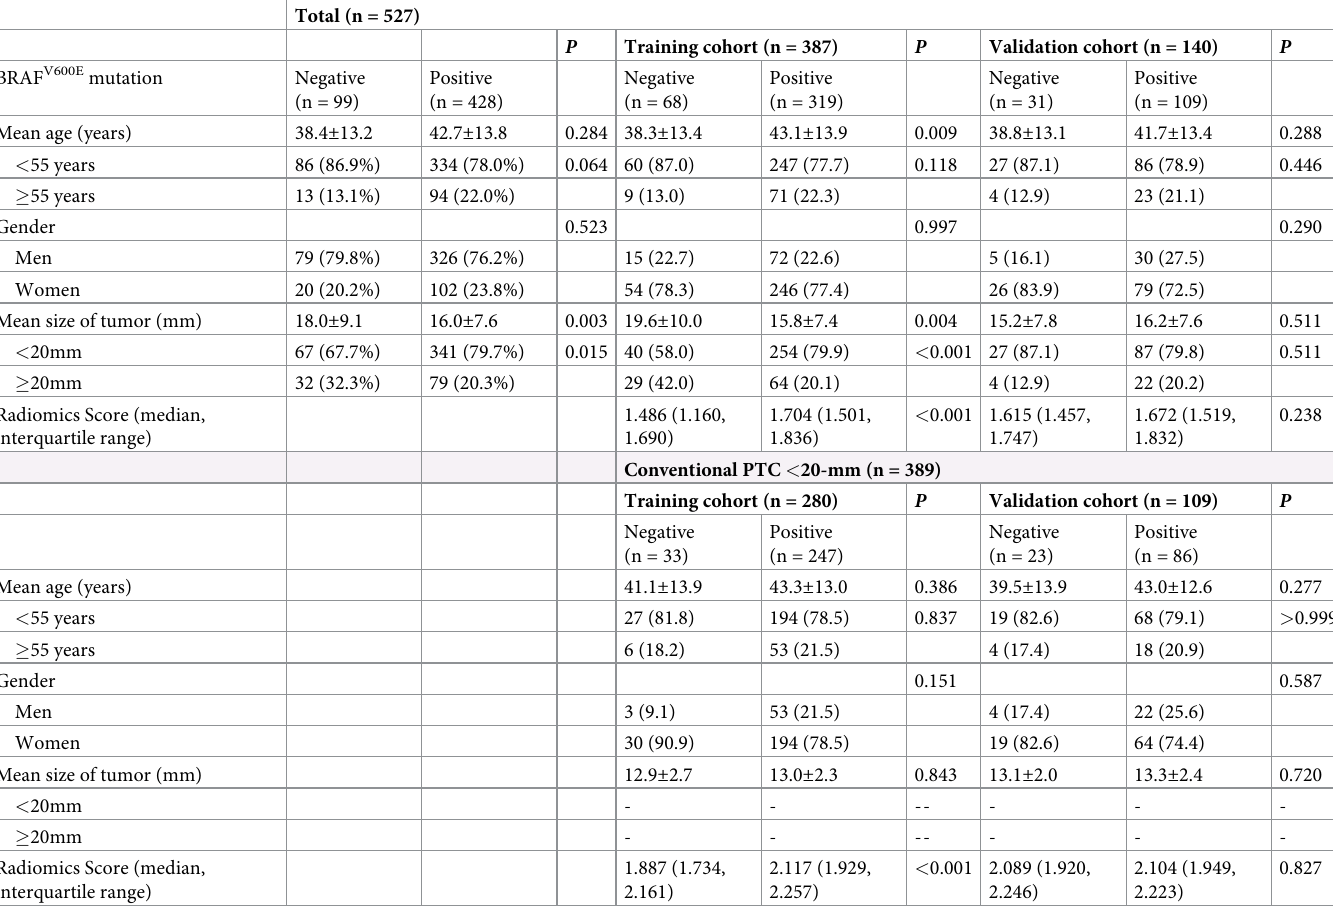
Table 1. Demographic features of the total thyroid cancers and conventional PTCs < 20-mm according to the presence of BRAF V600E